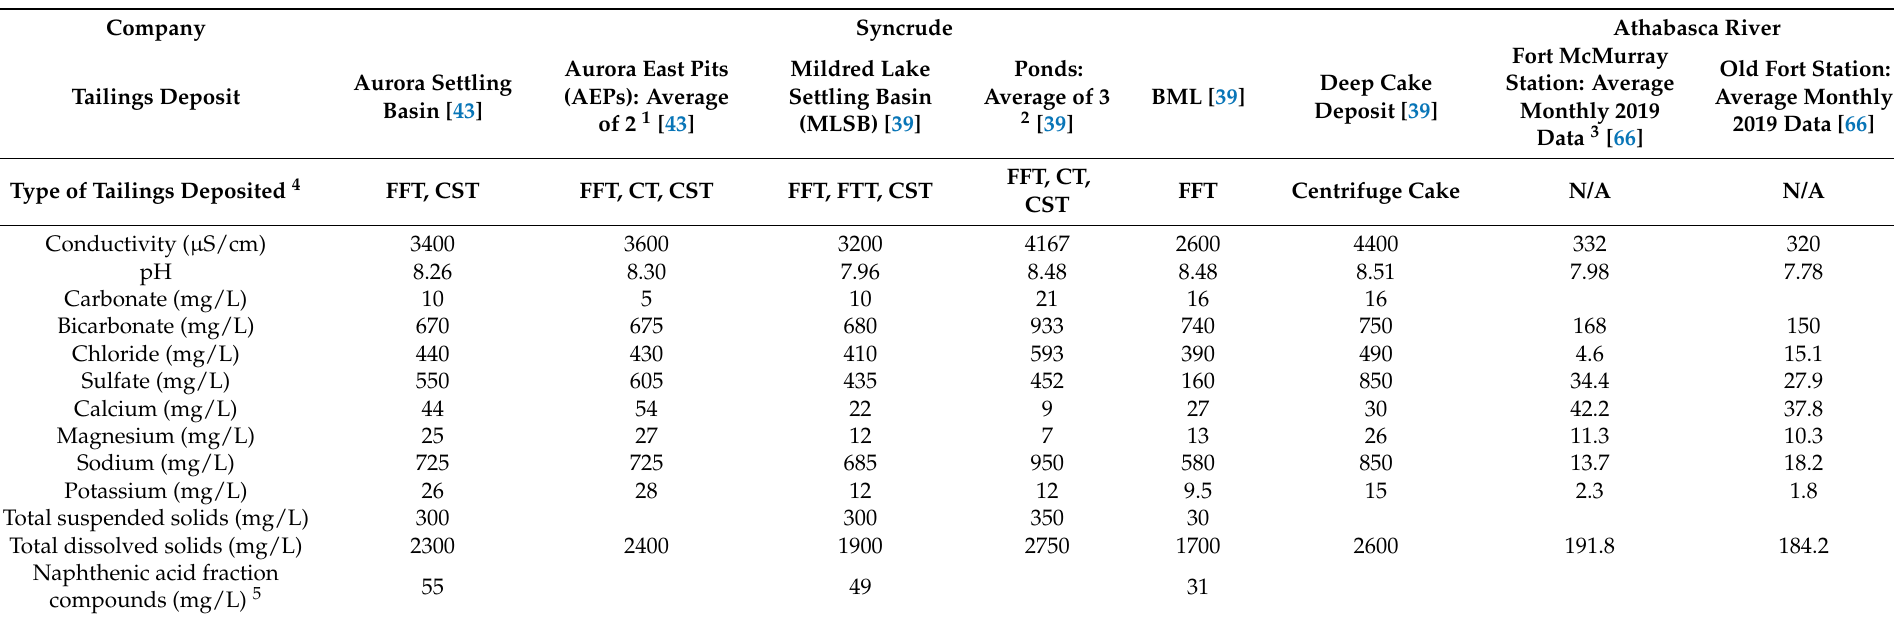
Table 3. Year 2019 surface water chemistry for Syncrude oil sands tailings deposits with ponded surface water in Alberta. Tailings deposits include tailings ponds, temporary dedicated disposal areas (DDAs), deep in-pit deposits, and EPLs. Surface water chemistry from the nearby Athabasca River is provided for comparison. Table 2 contains 2019 surface water chemistry for Imperial, Canadian Natural Resources Ltd. (CNRL), and Suncor oil sands tailings